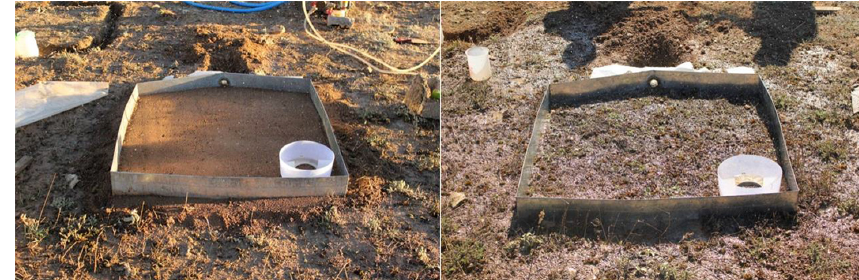
Figure 2. Views of the plots in both soil treatments; before soil preparation (right) and after soil preparation